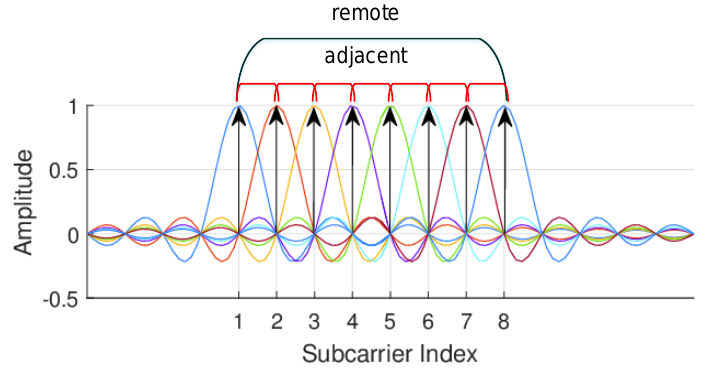
Figure 7. Spectra of orthogonal frequency-division multiplexing (OFDM) subcarriers in frequency domain. For simplifying the description, only 8 consecutive subcarriers are selected.